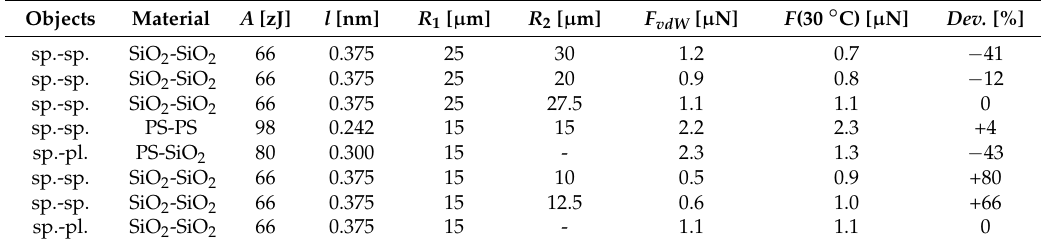
Table 3. Comparison of the measured pull-off forces ( F ) with calculated van der Waals forces ( F vdW ).